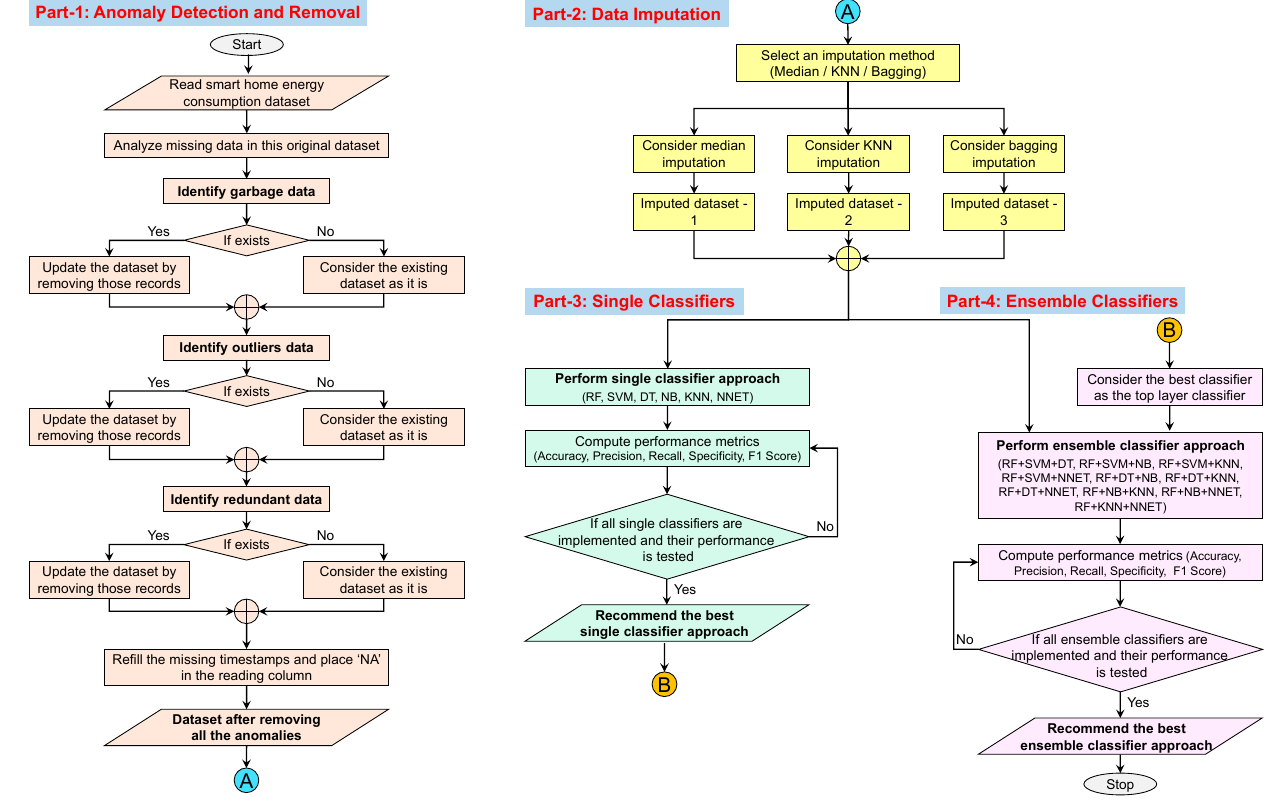
Figure 2. Implementation flow of the proposed approach.